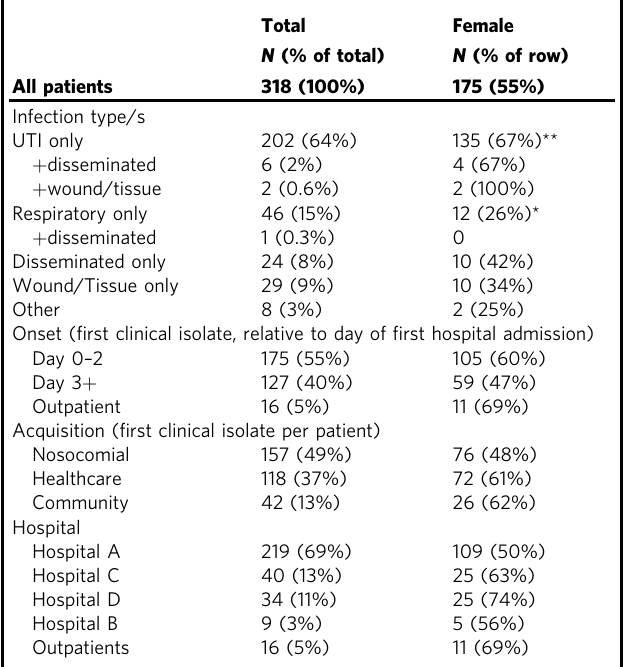
Table 1 Characteristics of patients with KpSC clinical